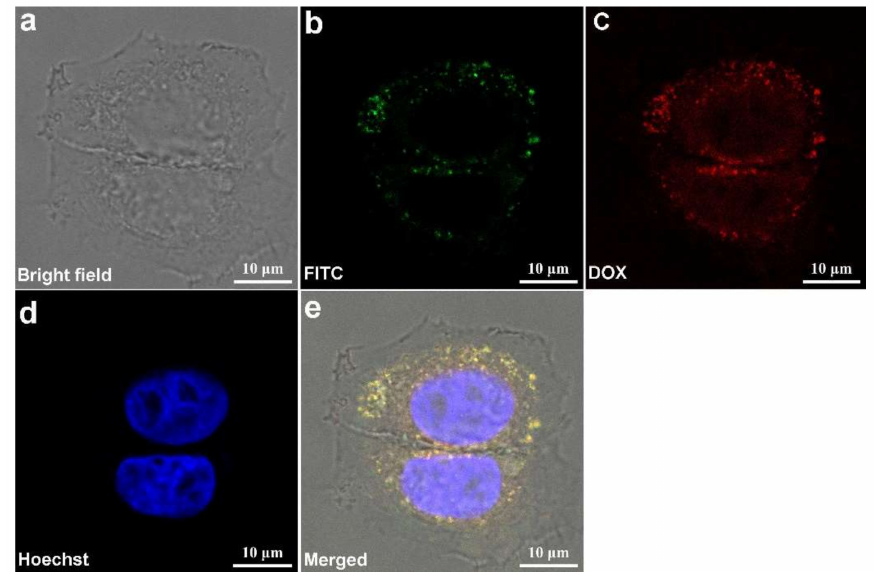
Figure 9. LSCM images of HL-7702 cells after incubation with FITC-labeled MSNs-SS-DMSA-DOX for 6 h.